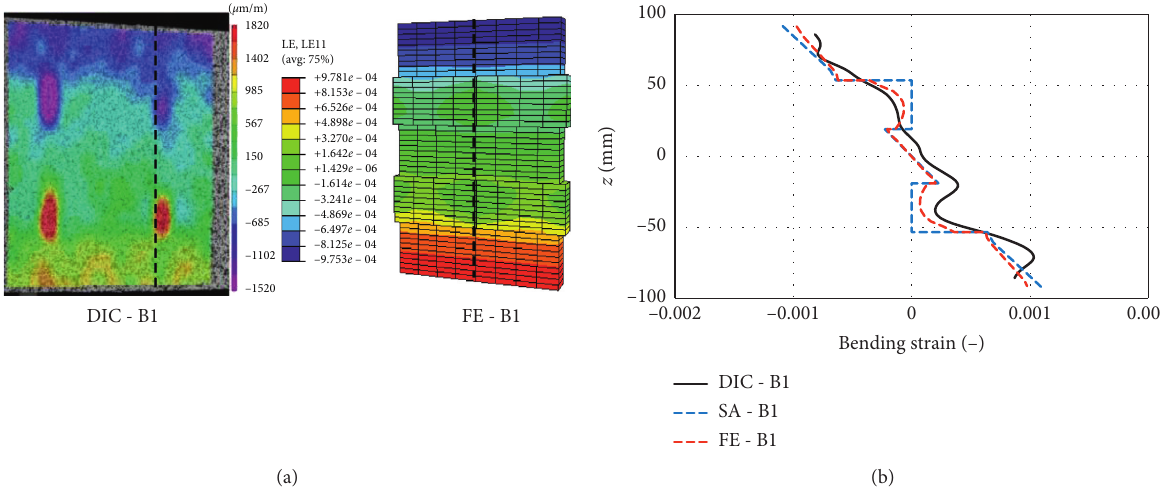
Figure 18: Colour contour plots and normal strain distribution from bending tests for